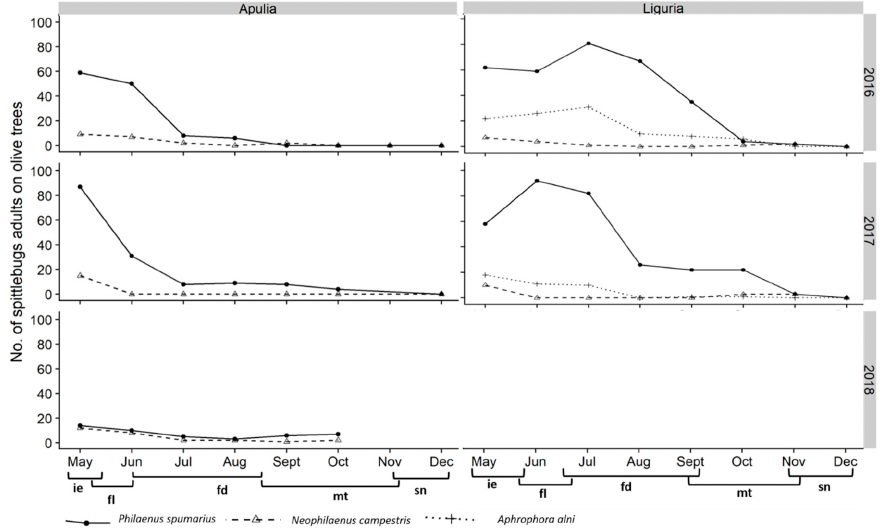
Figure 12. Abundance of spittlebug adults ( Philaenus spumarius , Neophilaenus campestris , Aphrophora stages of the crop, according to the BBCH scale (ie = inflorescence emergence; fl = flowering; fd = fruit development; mt = maturity of fruits; sn =